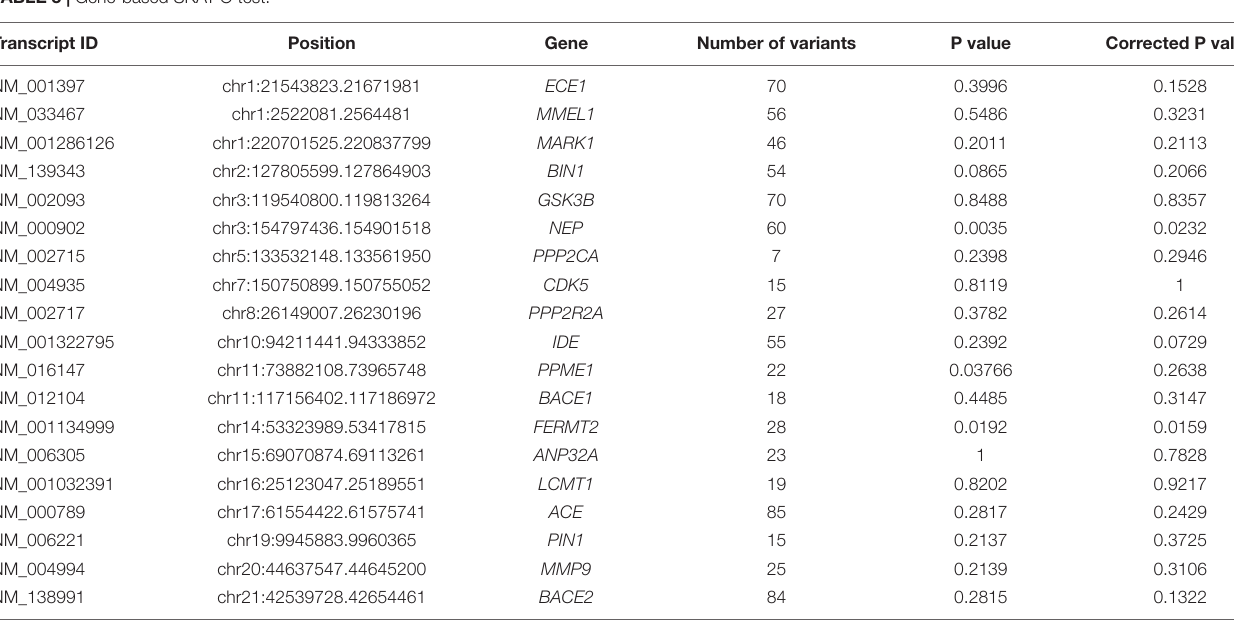
FIGURE 3 | Meta-analysis of NEP rs6665 (A) and rs701109 (B) in our study and reported studies. TABLE 3 | Gene-based SKAT-O